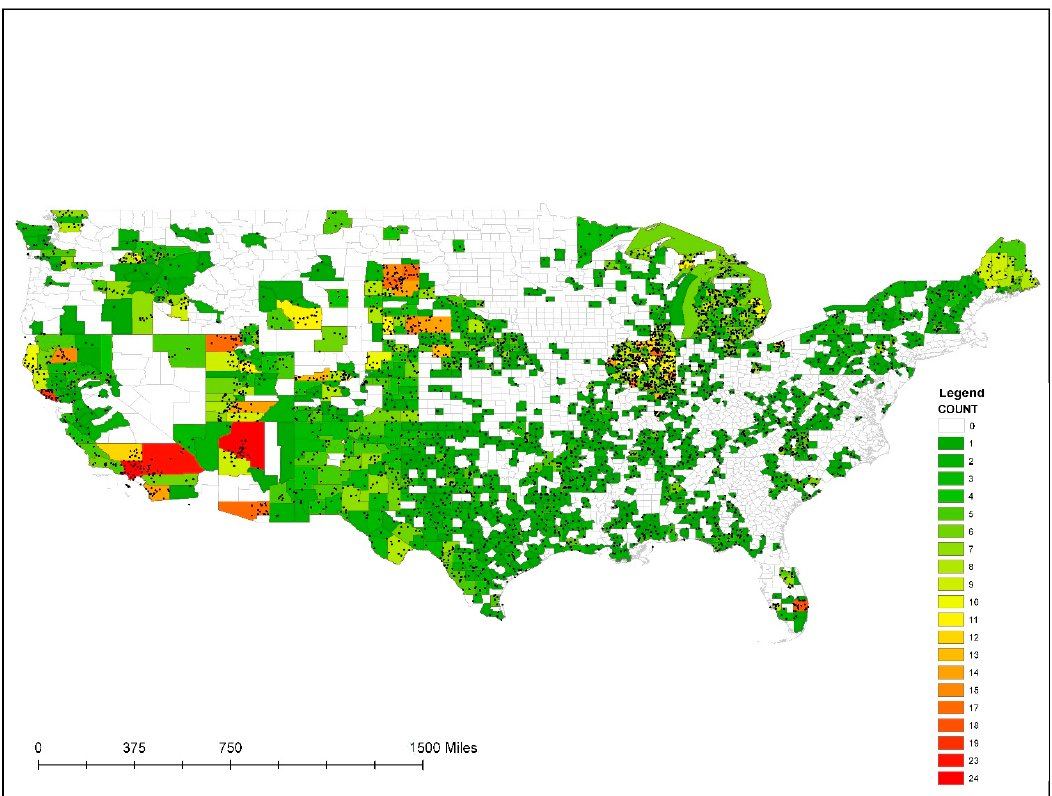
Figure 1. Locations of individual completely random sample files (black points), with a choropleth map showing number of files by county.